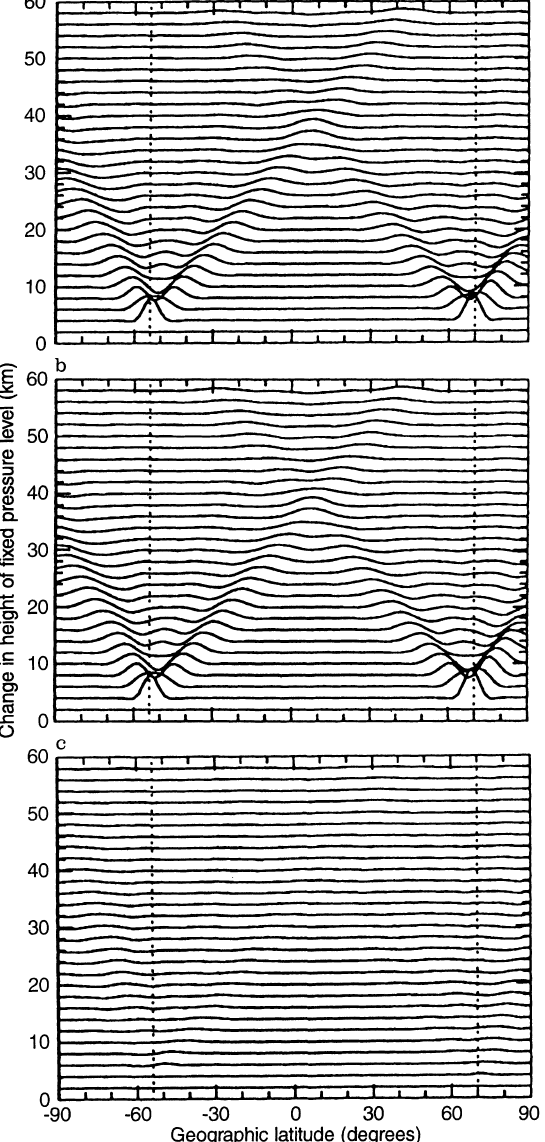
Fig. 4a–c. The change in the height of the fixed pressure level H12 plotted against latitude due to a short duration localised meridional enhanced electric field, with a Joule heating and Lorentz forcing, b Lorentz forcing due to the enhanced electric field artificially removed, c Joule heating due to the enhanced electric field artificially removed. The plotting convention is identical to that of